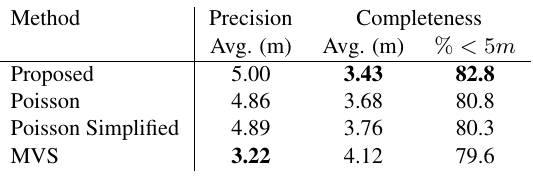
Table 1. Average precision and completeness (ignoring distances > 50 m ) on the Toronto dataset.